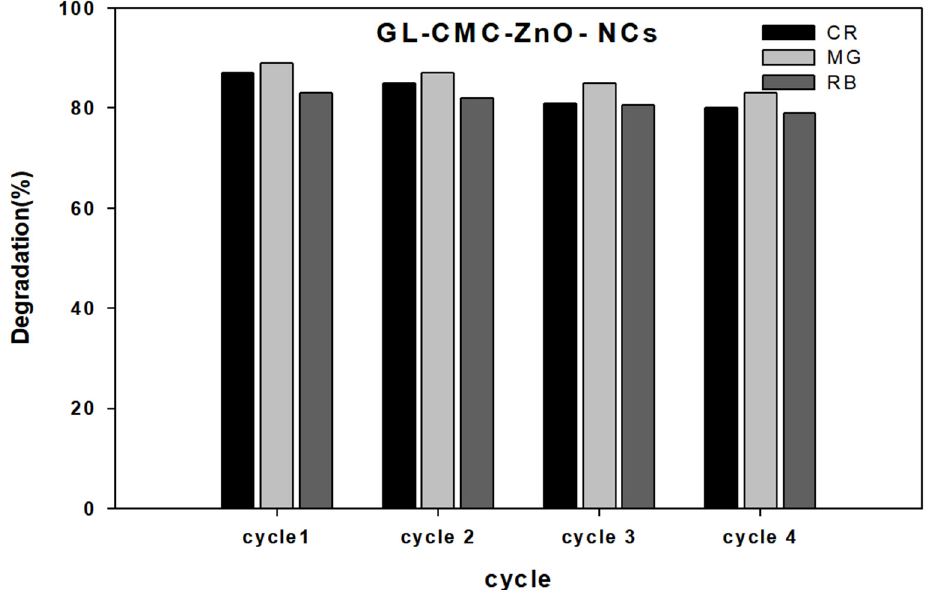
Figure 12. Reusability test results for the GL–CMC–ZnO NCs using dyes (CR, MG, and RB).